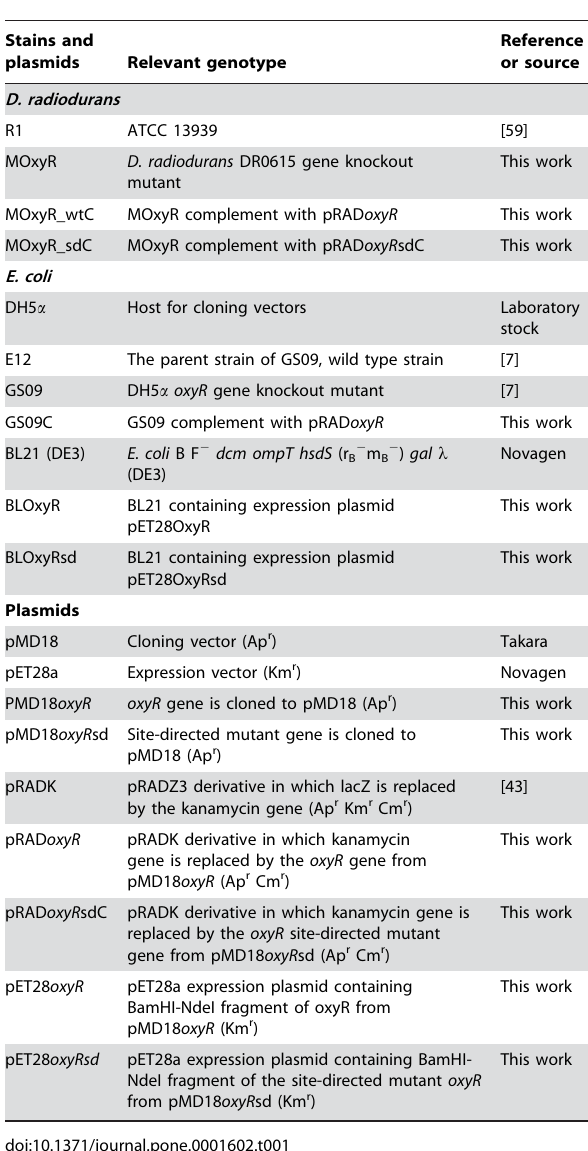
Table 2. Primers used in this